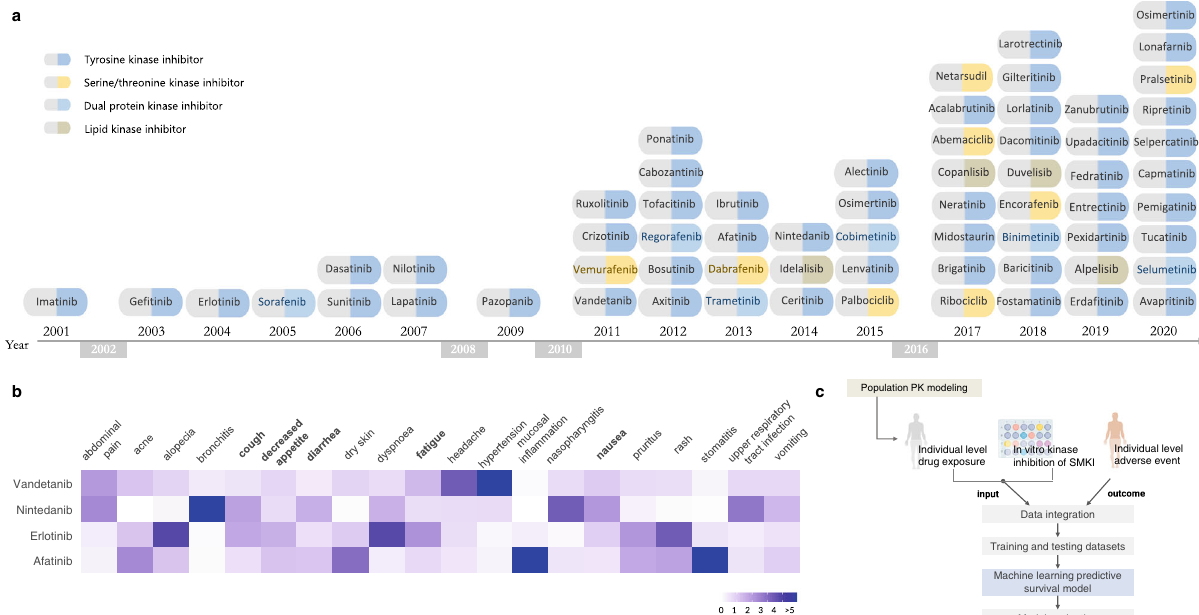
fi rst FDA approval date with their generic names. Source data were retrieved from theFDApublicwebsite. b Characteristicsof reportingoddsratio(ROR)pro fi lesfor combined top ten AEs of vandetanib, afatinib, erlotinib, and nintedanib. c The work fl ow of data integration and predictive